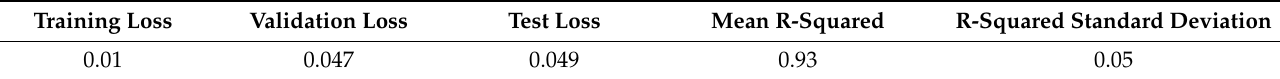
Table 5. Performance of the proposed model in terms of MSE losses and R-squared distribution for the test data set.